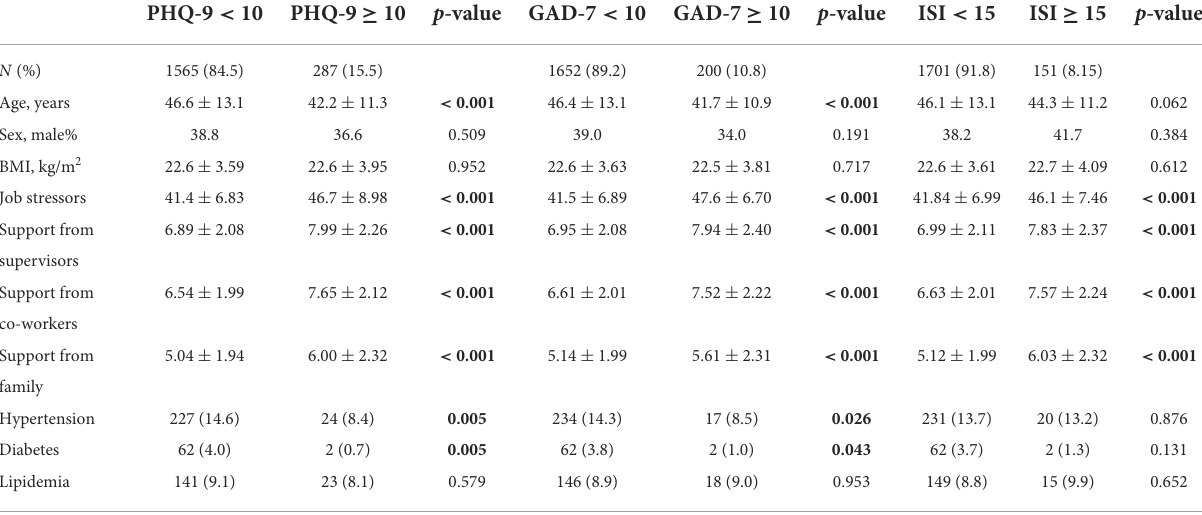
TABLE 2 Comparison between participants with and without depressive symptoms, anxiety symptoms, and insomnia.